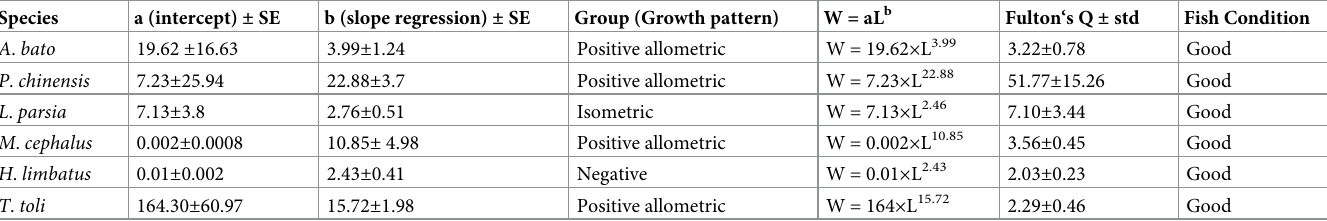
Table 4. Length-weight relationship, growth pattern and Fulton condition factor for the targeted fishes.